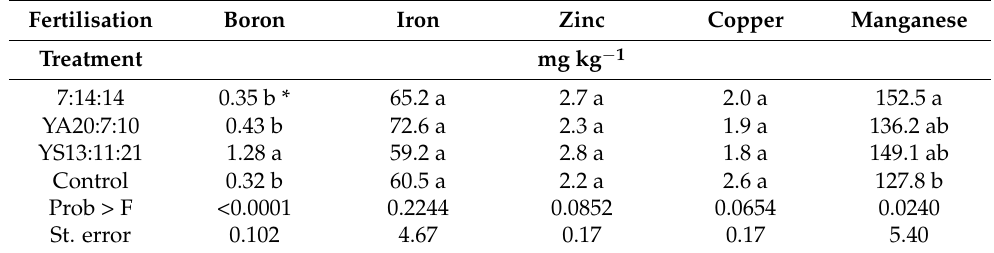
Table 5. Soil boron, iron, zinc, copper and manganese as a function of fertilisation